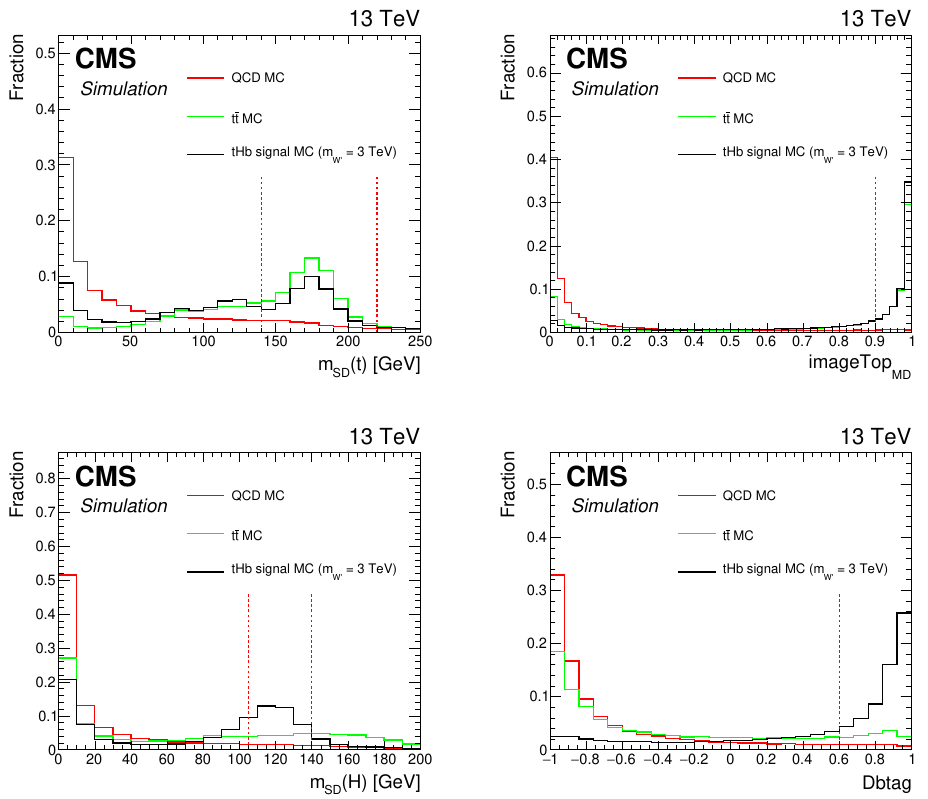
Figure 2 . Simulated distributions of the discriminating variables for tt , QCD, and tHb signal simulated events normalized to unity for the tHb analysis. Discriminant thresholds are shown as vertical dashed